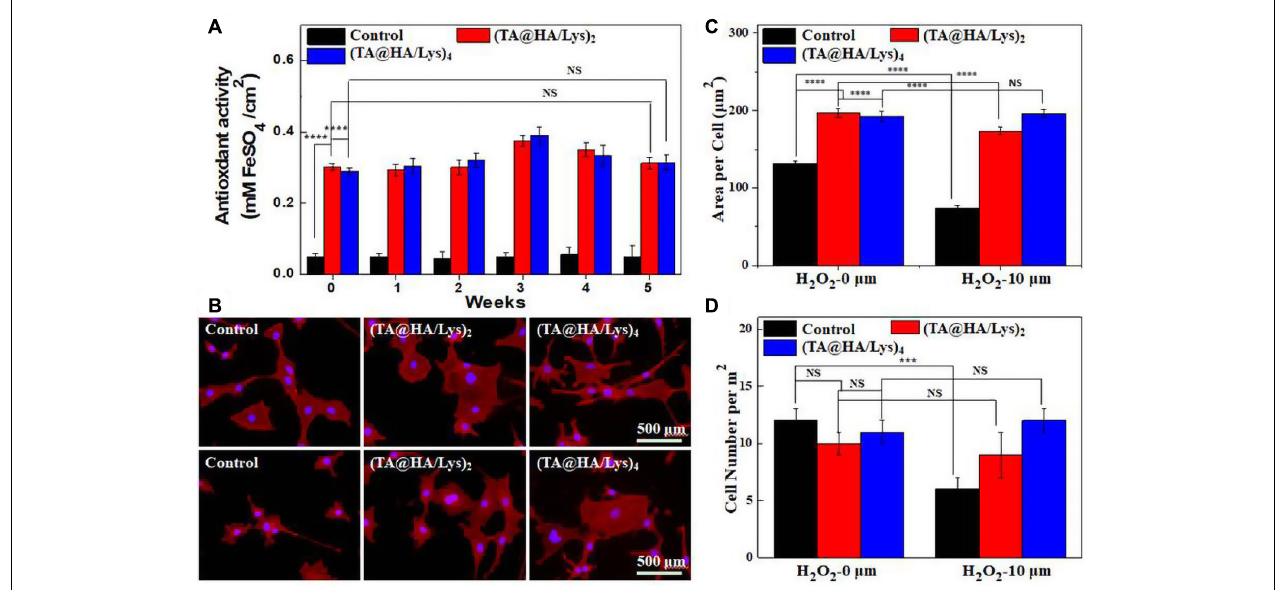
FIGURE 6 | (A) Antioxidant activities of glass coverslips as control, (TA@HA/Lys) 2 , and (TA@HA/Lys) 4 films evaluated by the fluorescence recovery after photobleaching (FRAP) method. (B) Fluorescence microscopy images of MC3T3-E1 cells cultured on glass coverslips as control, (TA@HA/Lys) 2 , and (TA@HA/Lys) 4 substrates before (top) and after (bottom) 10 µ M hydrogen peroxide (H 2 O 2 ) stimulation. (C) Cell area per cell and (D) cell number per mm 2 of MC3T3-E1 cells on the above substrates were determined without/with 10 µ M H 2 O 2 stimulation. All images were using the same scale bar. *** p < 0.001, **** p <